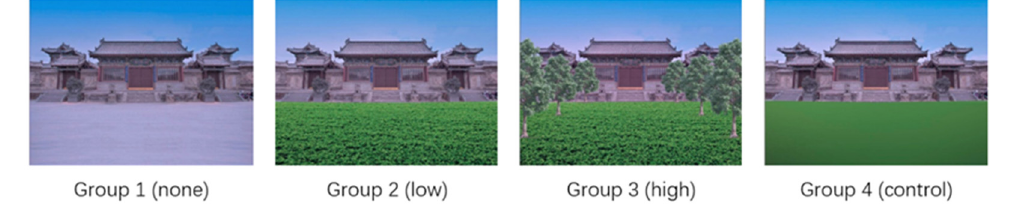
Figure 1. Four levels of greenery in a tourism scene.